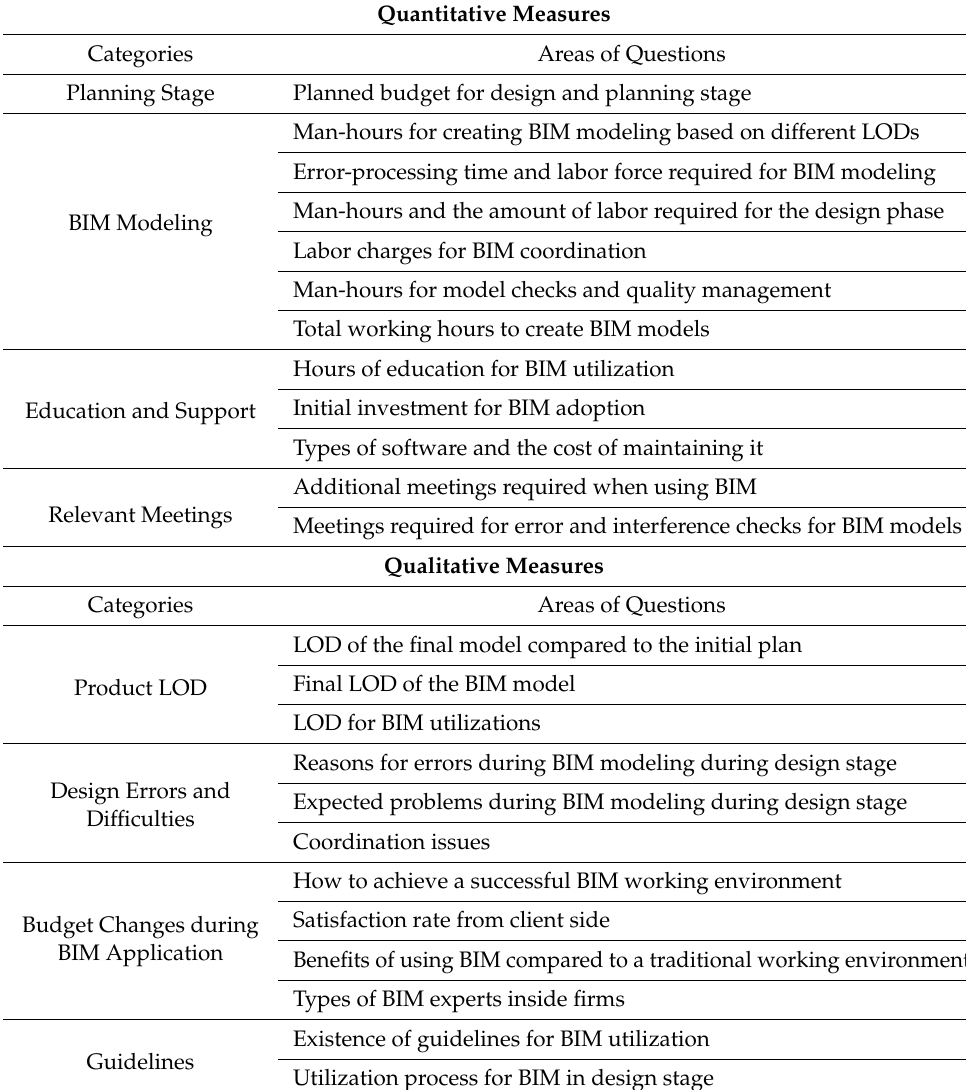
Table 2. Survey questions for quantitative and qualitative